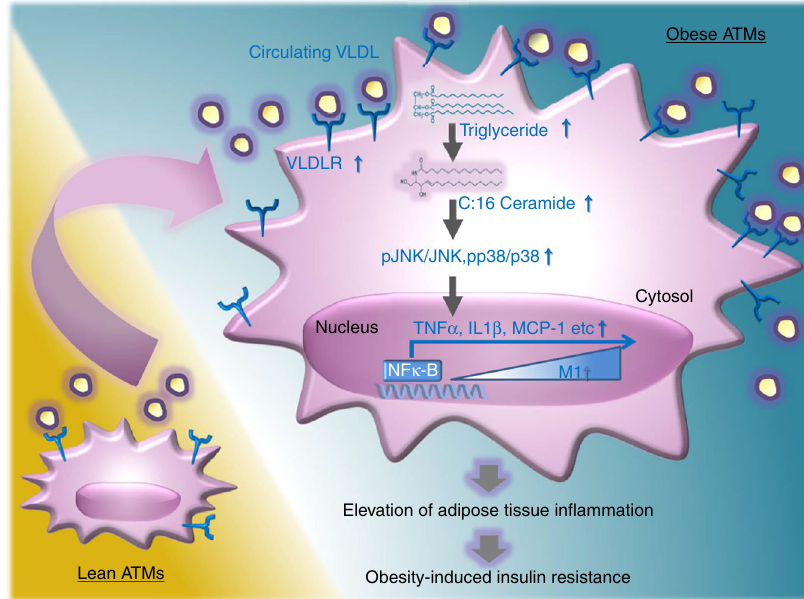
Fig. 9 Working model. In obese ATMs, VLDL – VLDLR axis stimulates adipose tissue in fl ammation, accompanied with obesity-induced insulin